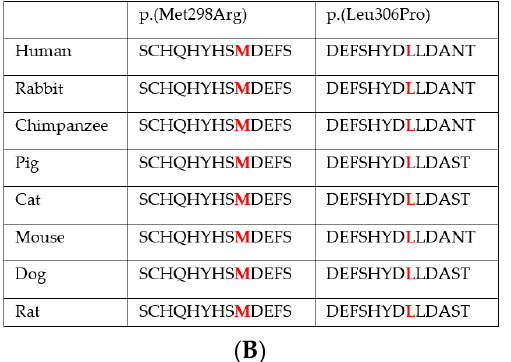
Figure 1. ( A ) Overview LOX protein and location of variants found in five new probands and literature. Variants leading to premature stop codons and missense variants are highlighted in, respectively, green and purple [4–7] . ( B ) Conservation of affected LOX amino acids.